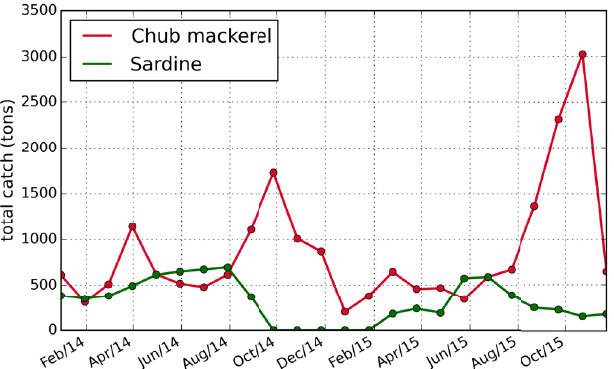
Fig. 2. Total monthly catches of chub mackerel (red) and sardine (green) for the two study areas off Portugal for 2014 and